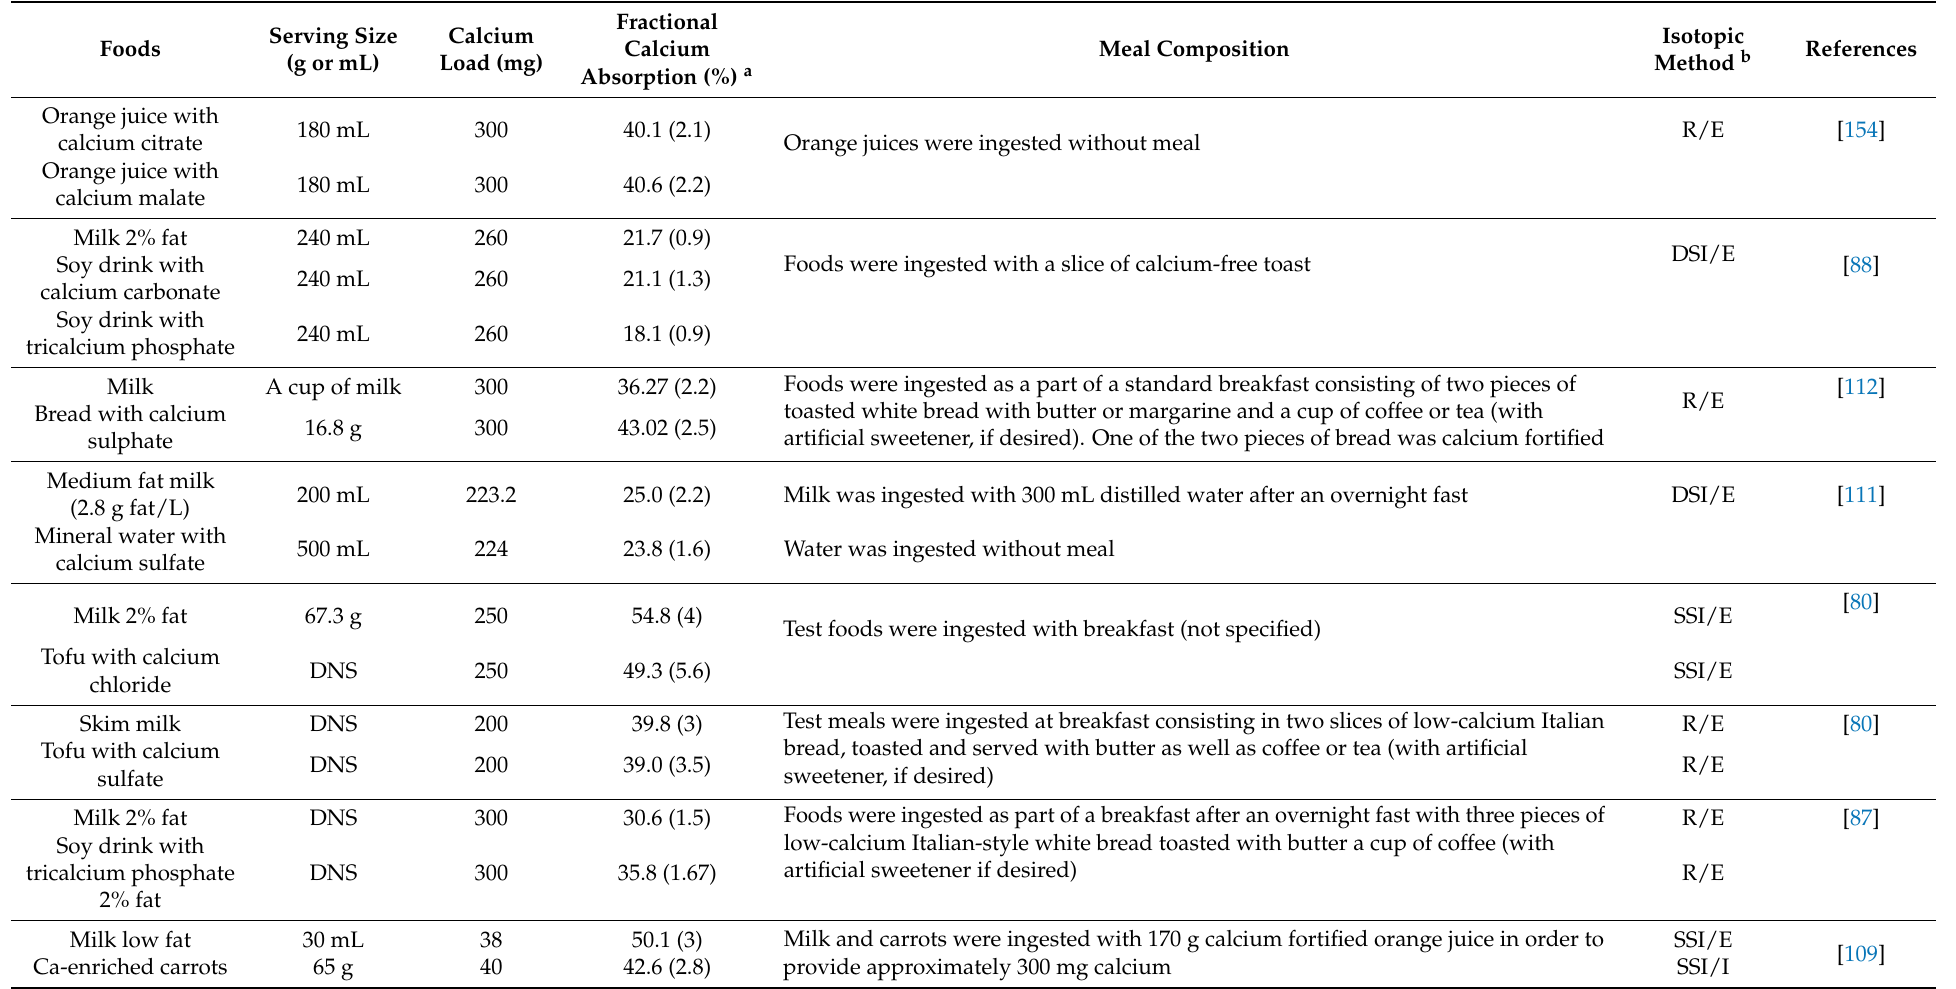
Table 8. Fractional absorption of calcium from calcium-fortified food